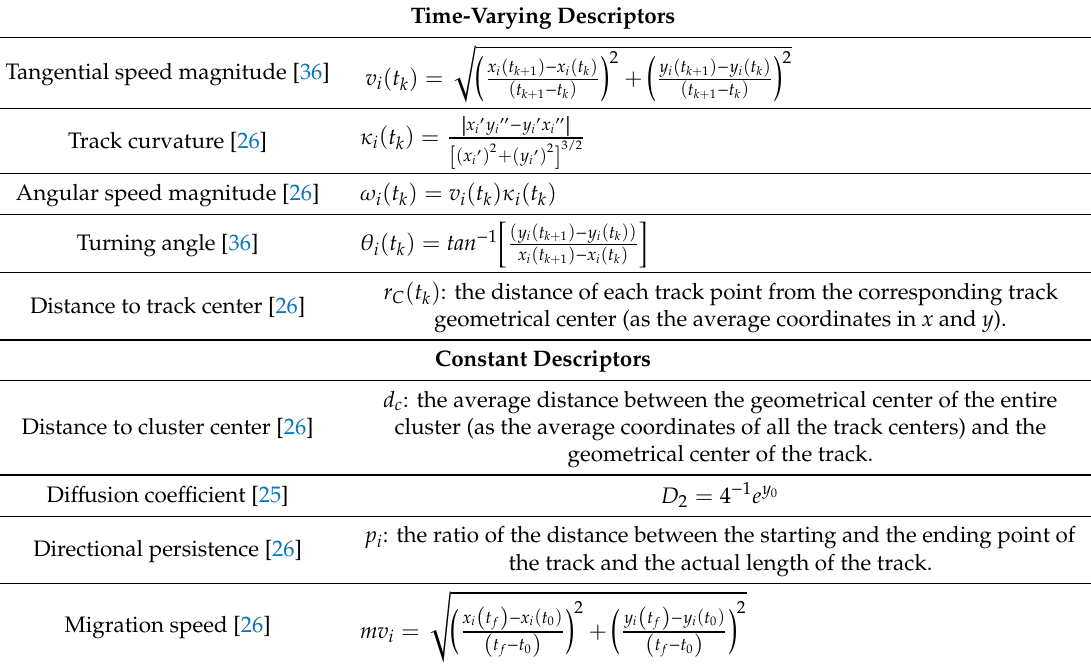
Table 1. List of the extracted kinematic descriptors. The index i denotes the i th cell track with coordinates ( x i ( t k ) , y i ( t k ) ), for t k = t 0 , ... , t f , where t 0 and t f the starting and the ending time instant of the track. For the track curvature, x (cid:48) , y (cid:48) and x (cid:48)(cid:48) , y (cid:48)(cid:48) are the first and second temporal derivatives, respectively, i i i i computed by finite di ff erence. For the di ff usion coe ffi cient, y 0 represents the y -axis intercept estimated from the Mean Square Displacement